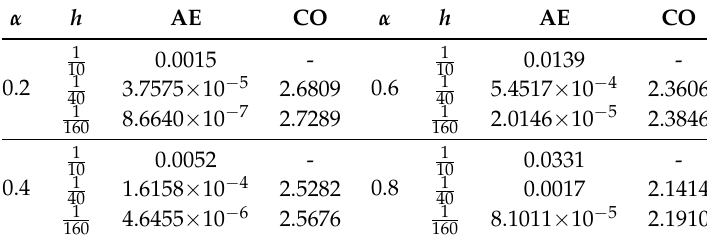
Table 3. Numerical results for Example